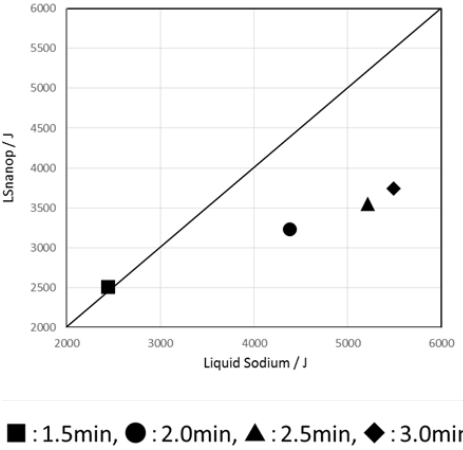
Figure 11. A comparison of the integrated heat of combustion between the LSnanop and liquid Na: The slanted line indicates the hypothetical case in which the integrated heat of combustion is same for the LSnanop and liquid